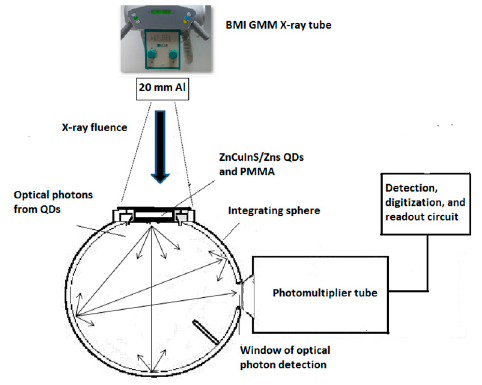
Figure 1. The experimental setup for ZnSCdS / ZnS quantum dot (QD) irradiation. Legend: PMMA, polymethyl methacrylate.